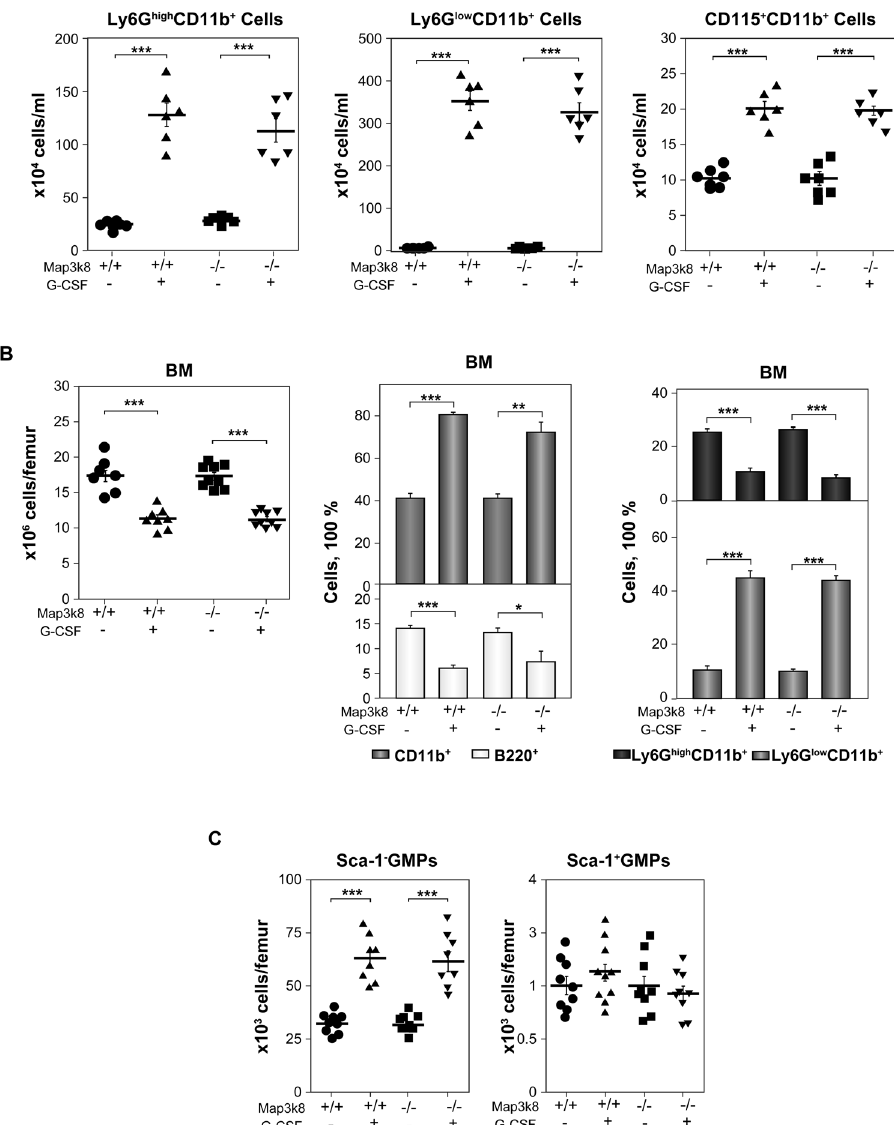
Figure 5. Granulopoiesis in G-CSF-treated Wt and Map3k8 − / − mice. ( A ) Wt and Map3k8 − / − mice received an i.p. injection of 6 μ g of G-CSF (r-metHuG-CSF, Filgrastim) daily on three consecutive days, and circulating myeloid cells were analysed 24 h later. The number of circulating Ly6G high CD11b + mature and Ly6G low CD11b + immature neutrophils and CD115 + CD11b + monocytes is shown. The data are presented as the mean ± SEM from two different experiments performed in triplicate. ( B ) Total cellularity of the BM and frequency of BM B220 + B and CD11b + myeloid cells and Ly6G high CD11b + mature and Ly6G low CD11b + immature neutrophils. The frequency of the various cells was calculated relative to total BM cells. ( C ) Isolated BM LIN − cells were subjected to FACS analysis, and the numbers of Sca-1 − GMPs and Sca-1 + GMPs per femur were calculated. ( A – C) The data are presented as the mean ± SEM of two or three different experiments performed in triplicate. One-way ANOVA with Newman-Keuls correction was used. * p < 0.05, ** p < 0.01, *** p <